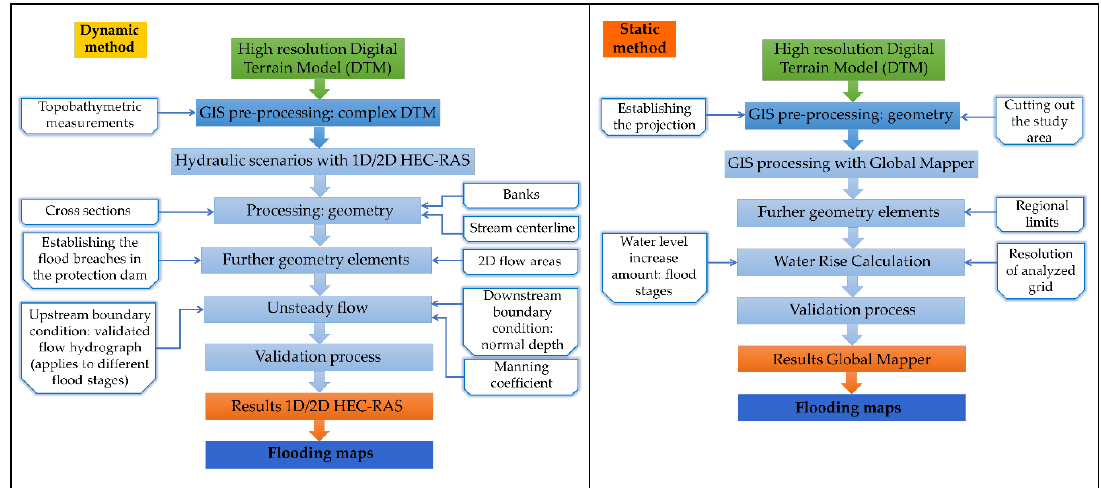
Figure 4. Diagram indicating the methodology considered in the present work, and which describes the main